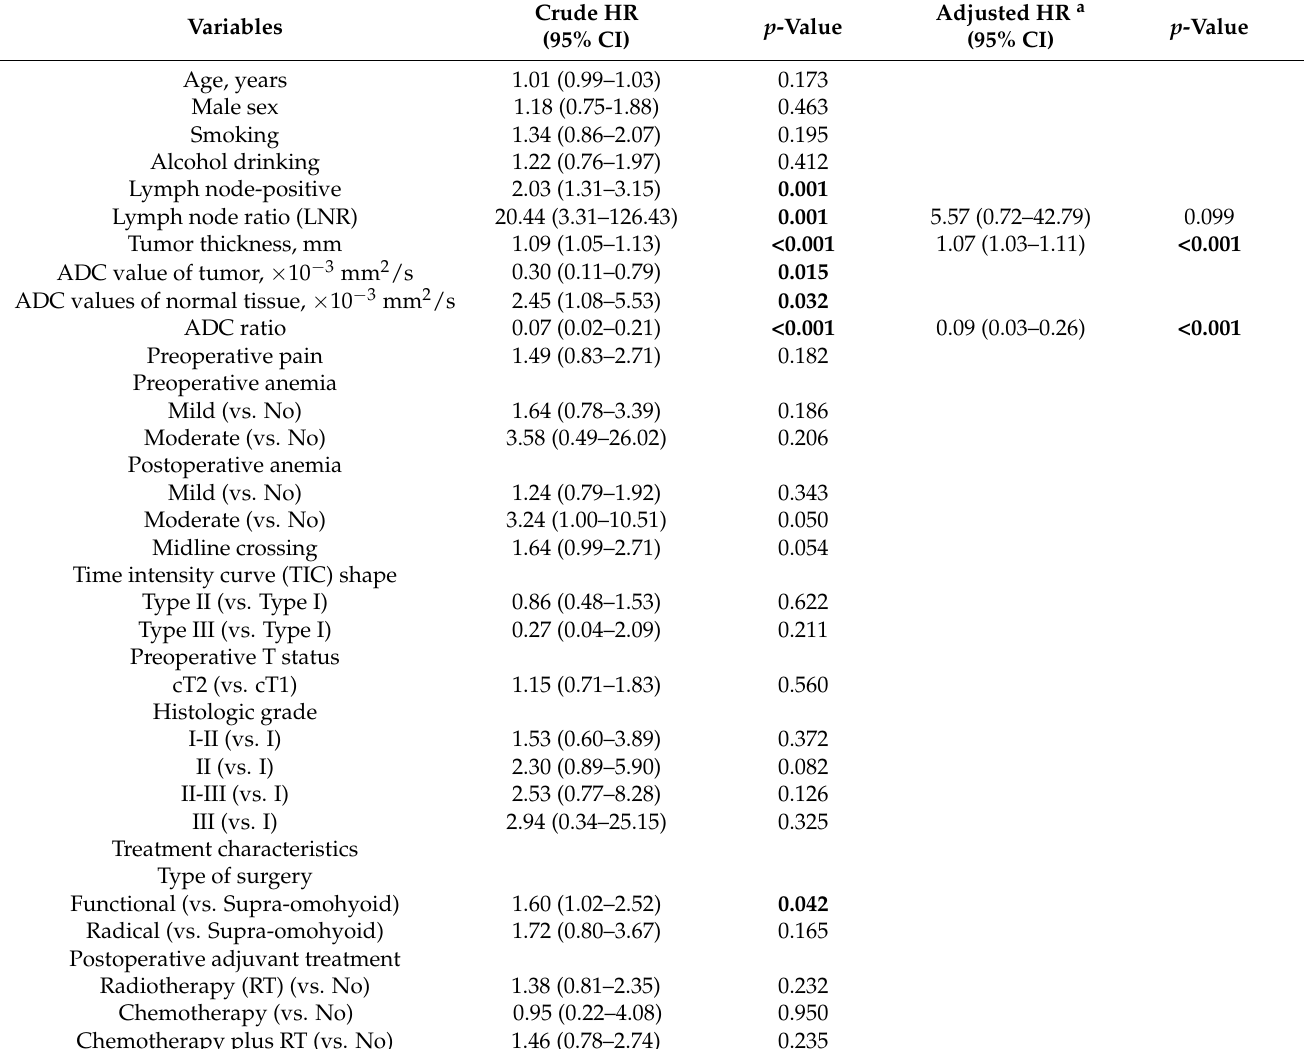
Table 2. Crude and Adjusted Hazard Ratios for Recurrence in Different Clinical Characteristics